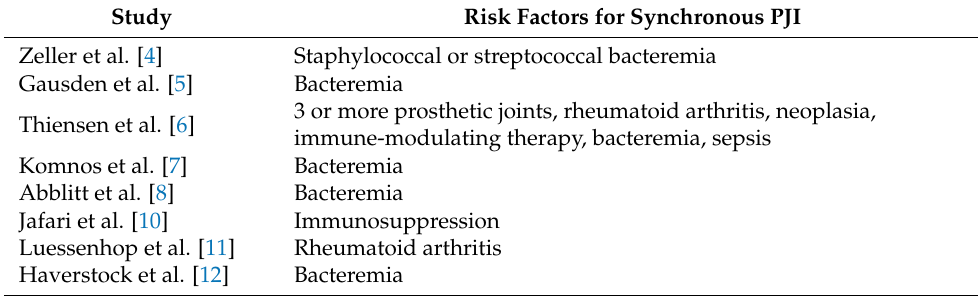
Table 5. Risk factors for synchronous